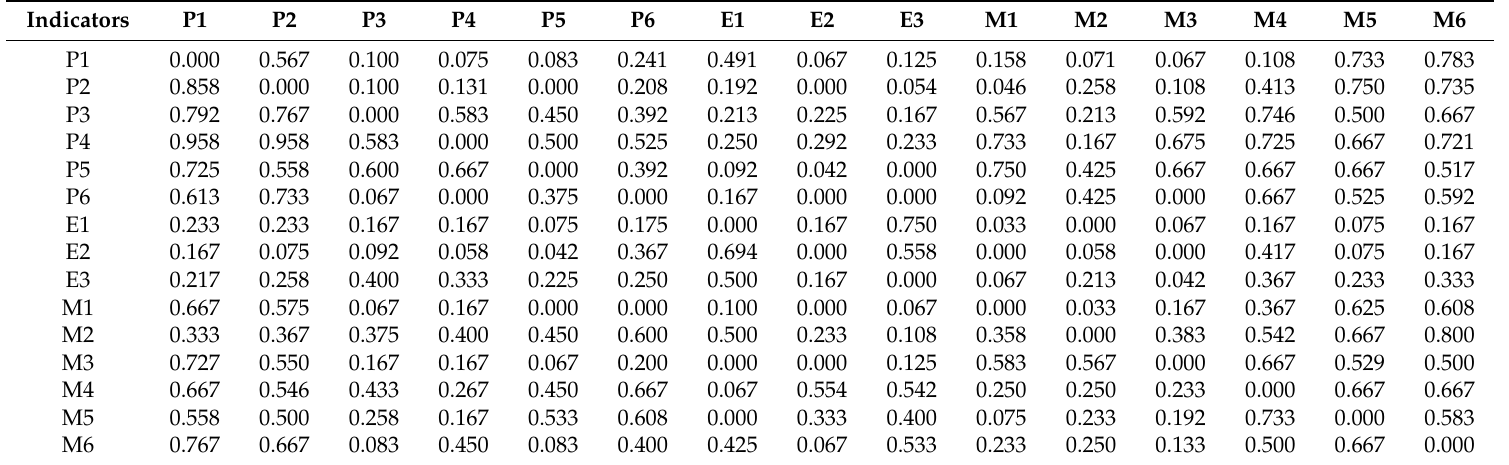
Table 4. Initial direct-influence matrix Z